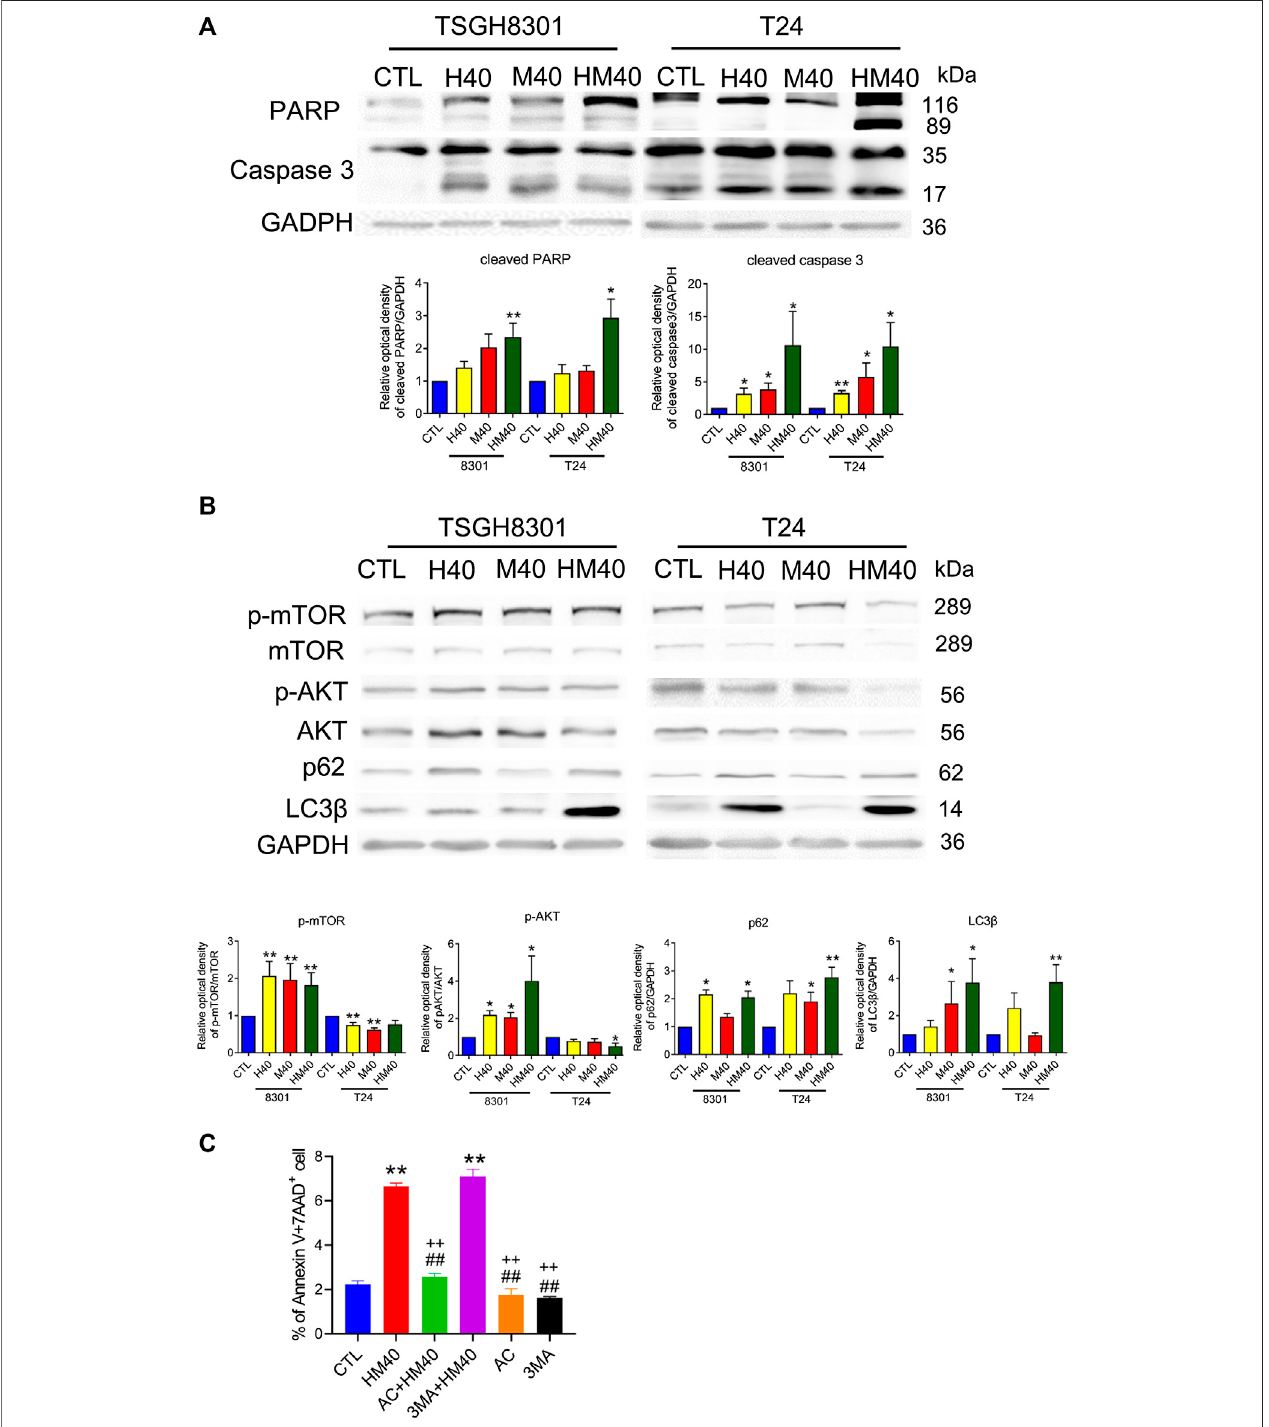
FIGURE3| Hono-Magpromotedapoptosisandautophagy-associatedproteinsinbladdercancercells.TSGH8301andT24bladdercellsweretreatedwithHono, Mag, or Hono/Mag (40 μ M) for 24 h. (A) The cell lysates were analyzed for the apoptotic-related proteins cleaved caspase 3 and cleaved PARP by Western blotting. (B) The cell lysates were analyzed for the autophagy-associatedproteinsp-AKT, AKT, p62, and LC3 β . GAPDH wasused asthe loading control. The lowerpanels show the resultsofquantitativeproteinanalyses. (C) TSGH8301bladdercancercellsweretreatedwithHono/Mag(40 μ M),Ac-DEVD-CHO(AC)+Hono/Mag,3MA+Hono/ Mag, AC, or 3 MA for 24 h. The proportions of apoptotic cells were determined using Annexin V/7AAD staining and fl ow cytometry analysis. * p < 0.05; ** p < 0.01 compared to the control group. ## p < 0.01 compared to the Hono/Mag group. ++ p < 0.01 compared to the 3 MA + Hono/Mag group.